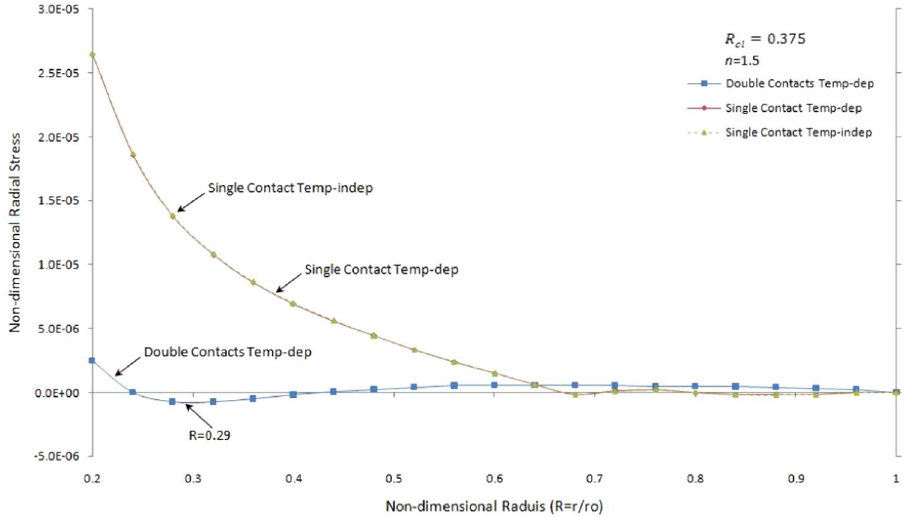
Figure 11. Non-dimensional radial stress versus the non-dimensional radius of one side contact with temperature-dependent and temperature-independent material properties and two side contacts under thermo- mechanical load in the FGMs rotating brake disk with R cl = 0.375 and n = 1.5.